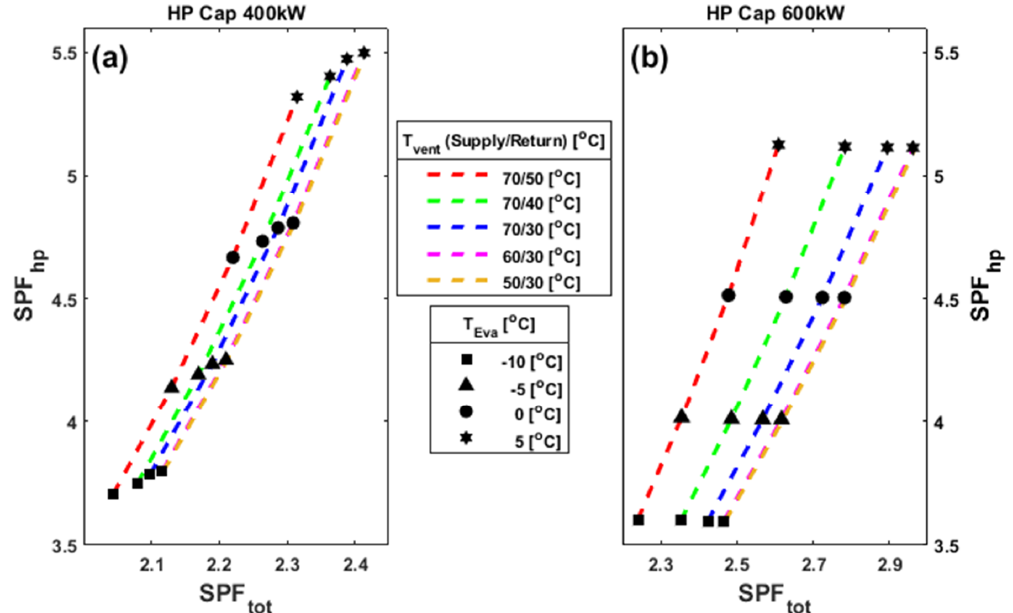
Figure 4. The influence of the evaporator temperature, ventilation temperature ratio, and the heat pump capacity: ( a ) 400 kW; ( b ) 600 kW on the heat pump and total SPF values.